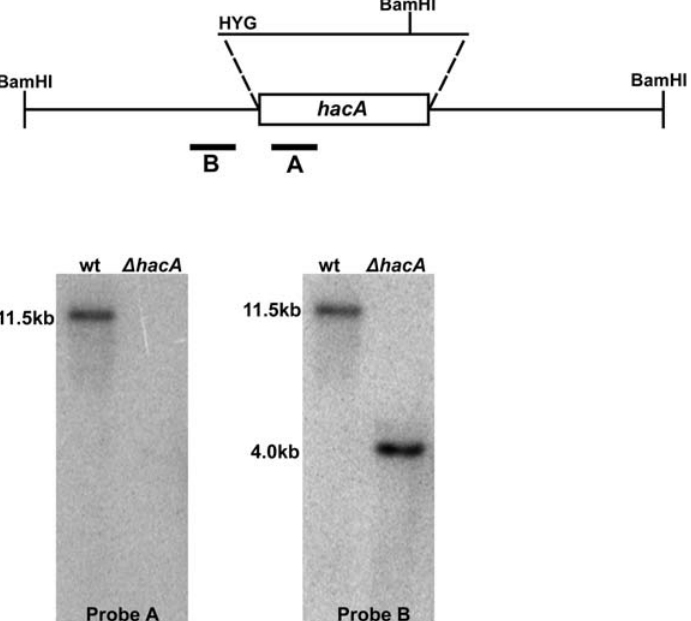
Figure 2. Disruption of hacA . Deletion strategy: The hacA gene was deleted by replacing the coding region with the hygromycin resistance cassette (HYG). Southern blot analysis of Bam HI–digested genomic DNA using Probe B (flanking region) identified the predicted 11.5 kb wt band which was truncated to 4.0 kb in the D hacA mutant. A second probe (Probe A) derived from the deleted region of the hacA gene was used to confirm that no duplication had occurred.